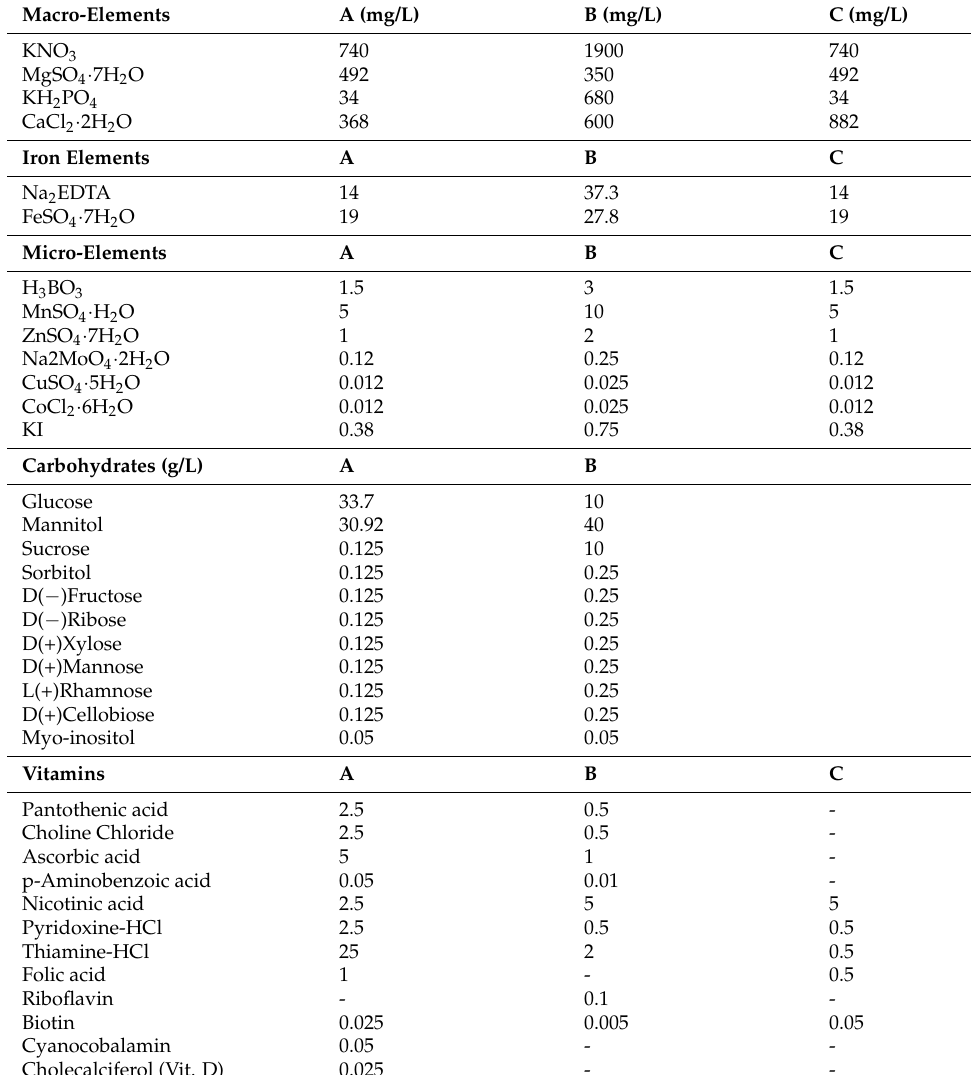
Table 6. Stock solutions for medium